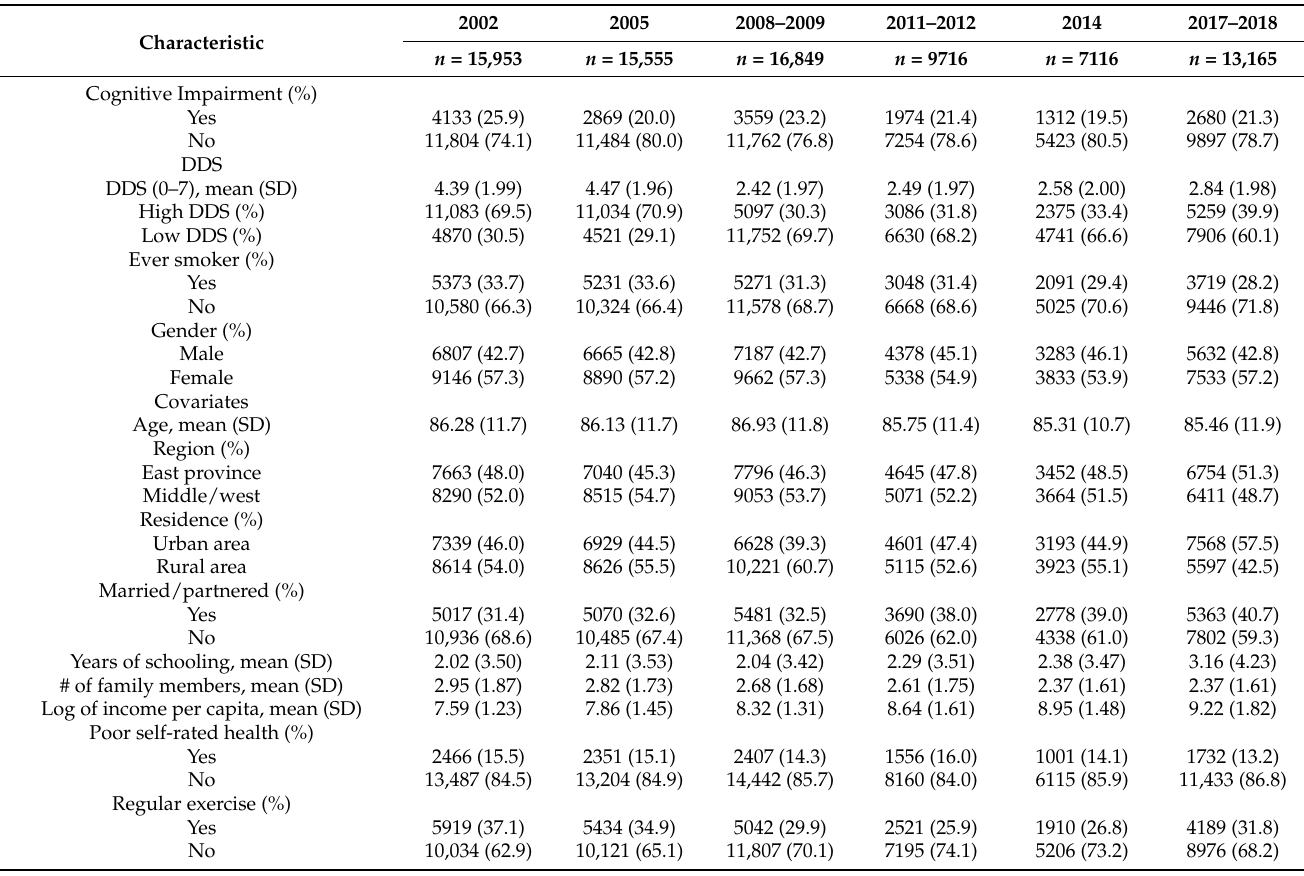
Table 1. Characteristics of the study samples in each of the six waves of CLHLS 2002–2018.